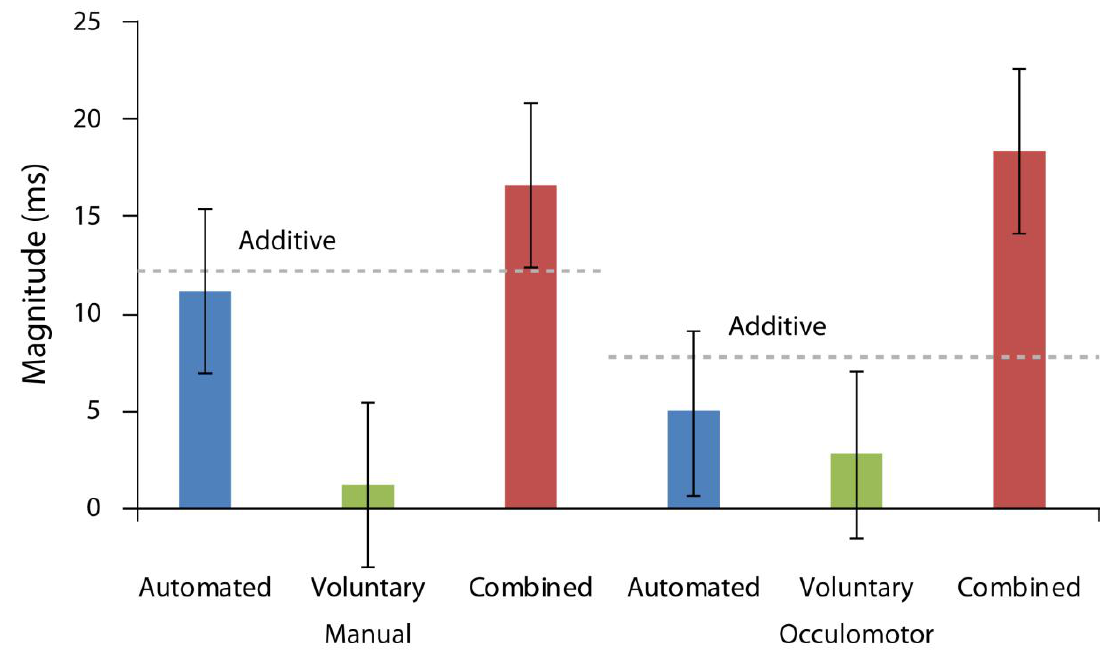
Figure 3. Additivity analyses. Magnitudes of attentional orienting (invalidly cued–validly cued response time) as a function of attention condition for manual and oculomotor conditions. Error bars indicate standard error of the di ff erence between